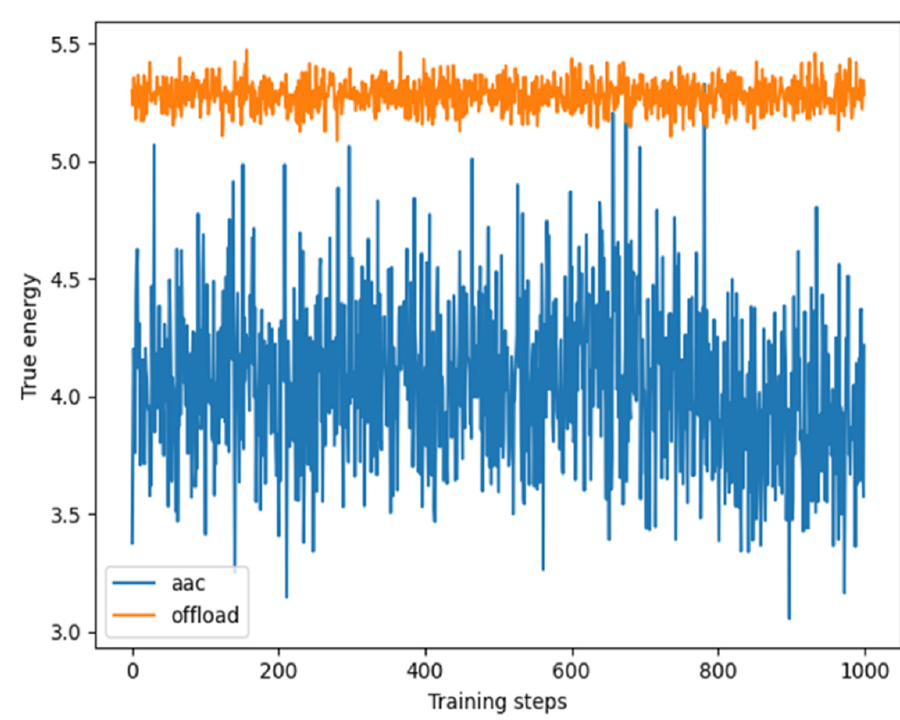
Figure 7. Total system energy consumption based on improved AAC multi-leakage real-time detec- tion algorithm with fully locally calculated system.